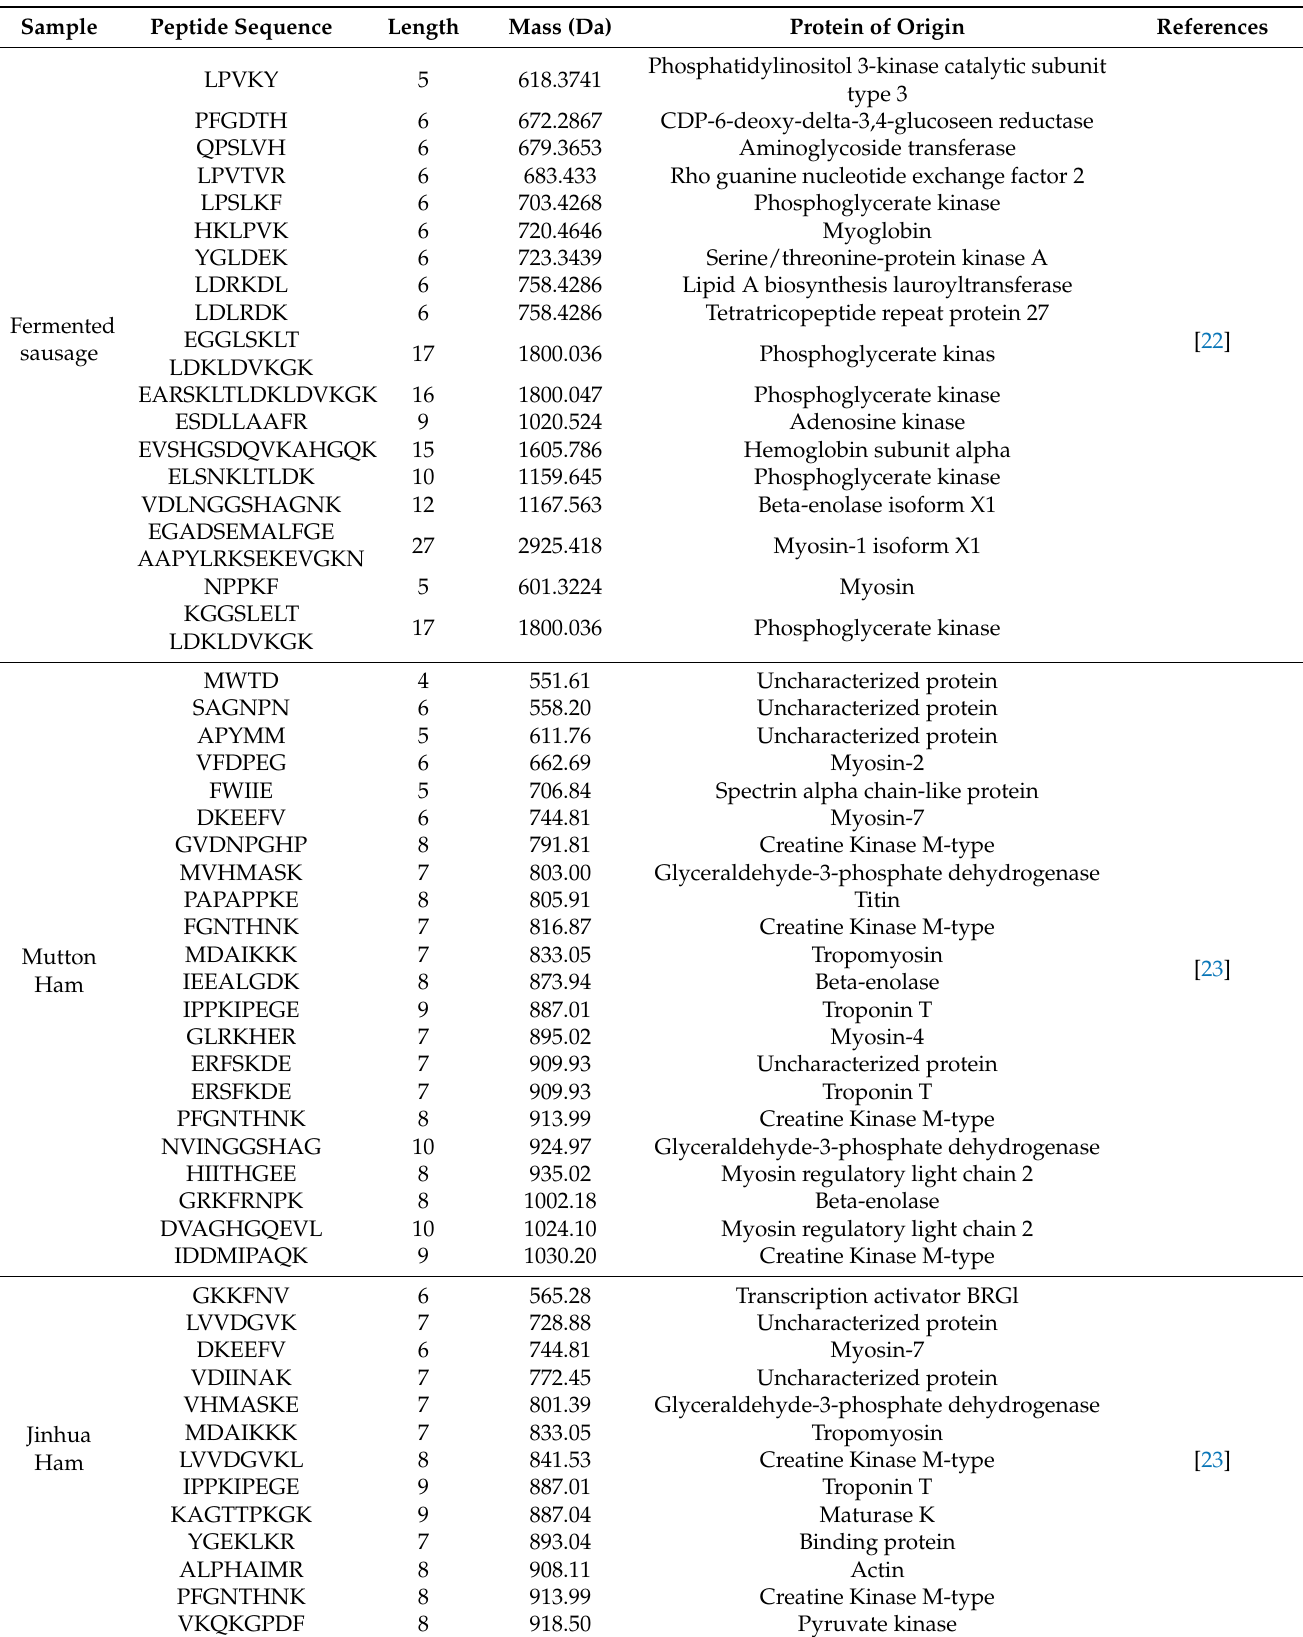
Table 1. Composition of Crude Peptide in Fermented